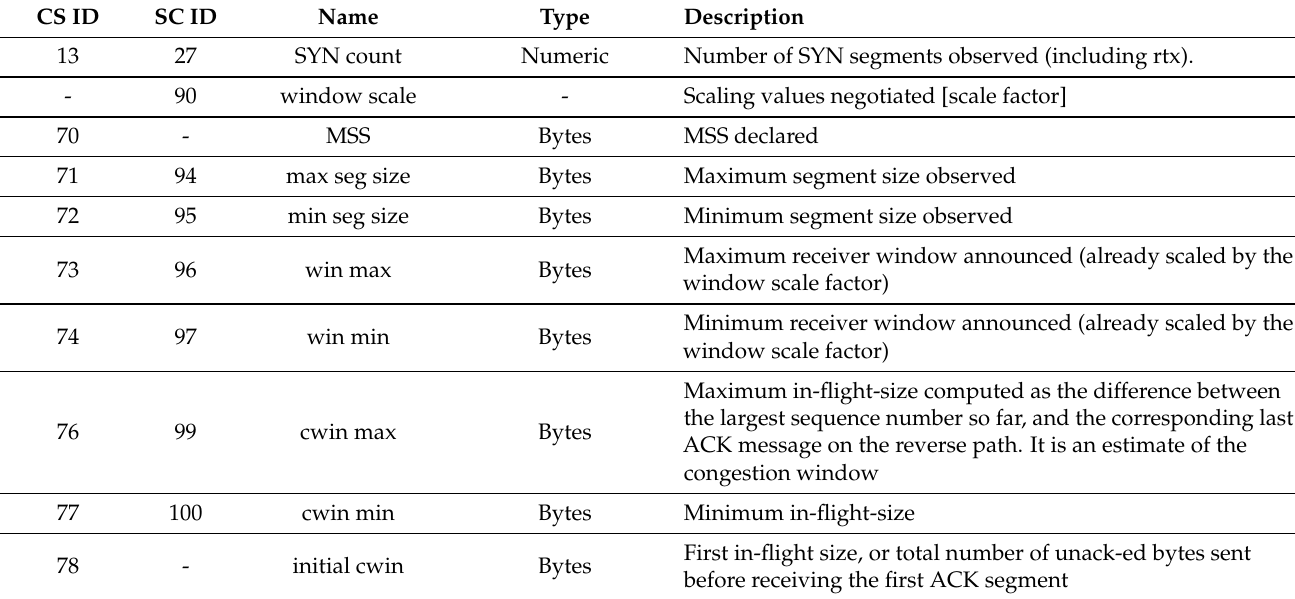
Table 2. Selected features of the Crypto dataset to train the baseline